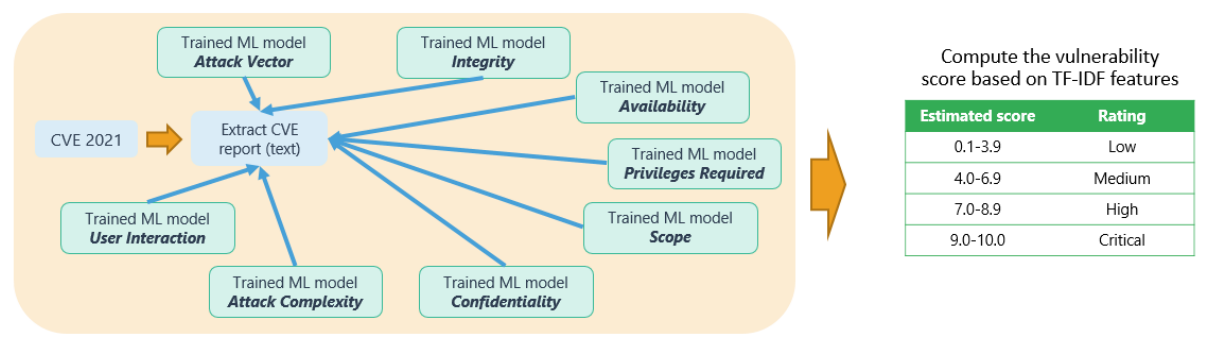
Figure 6. Unseen data evaluation phase.